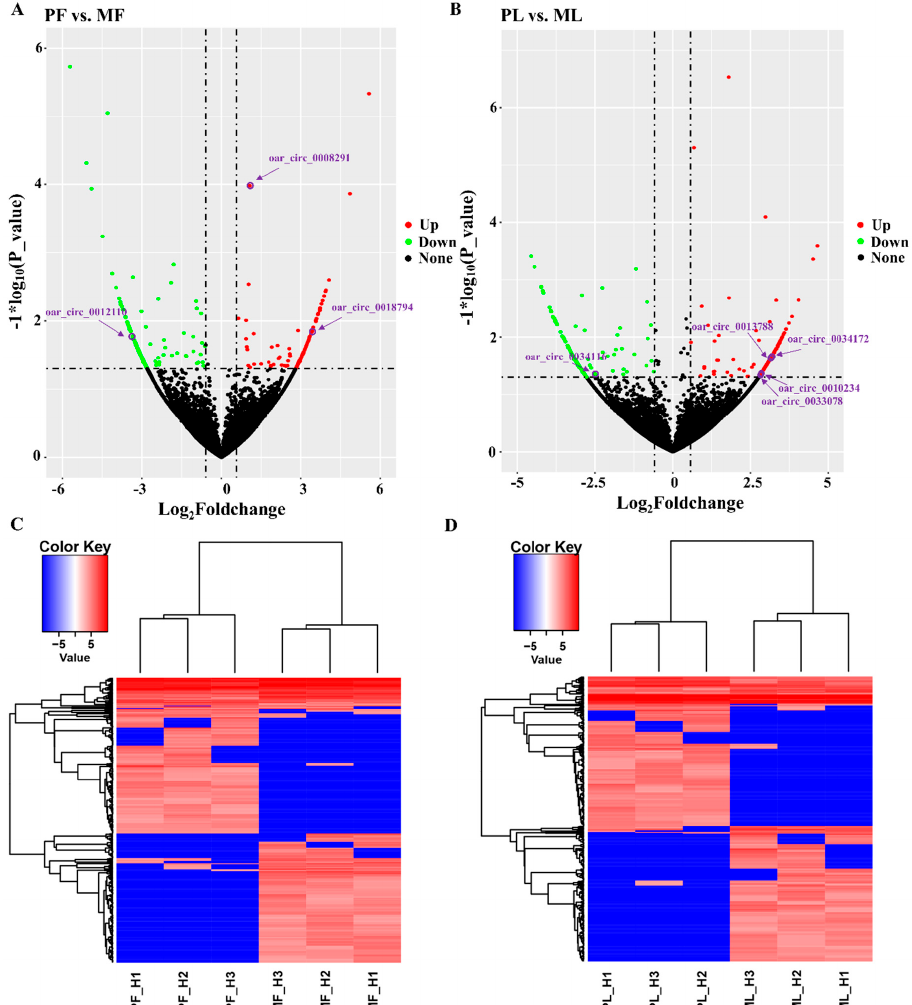
Figure 4. An overview of differentially expressed circular RNAs (DE circRNAs). ( A ) A volcanic plot in polytocous sheep in the follicular phase versus monotocous sheep in the follicular phase (PF vs. MF), in which several key circRNAs are also labeled. ( B ) A volcanic plot in polytocous sheep in the luteal phase versus monotocous sheep in luteal sheep (PL vs. ML), in which several key circRNAs are also labeled. ( C ) The expression pattern of DE circRNAs and hierarchical clustering analysis in PF vs. MF. ( D ) The expression pattern of DE circRNAs and hierarchical clustering analysis in PL vs. ML.